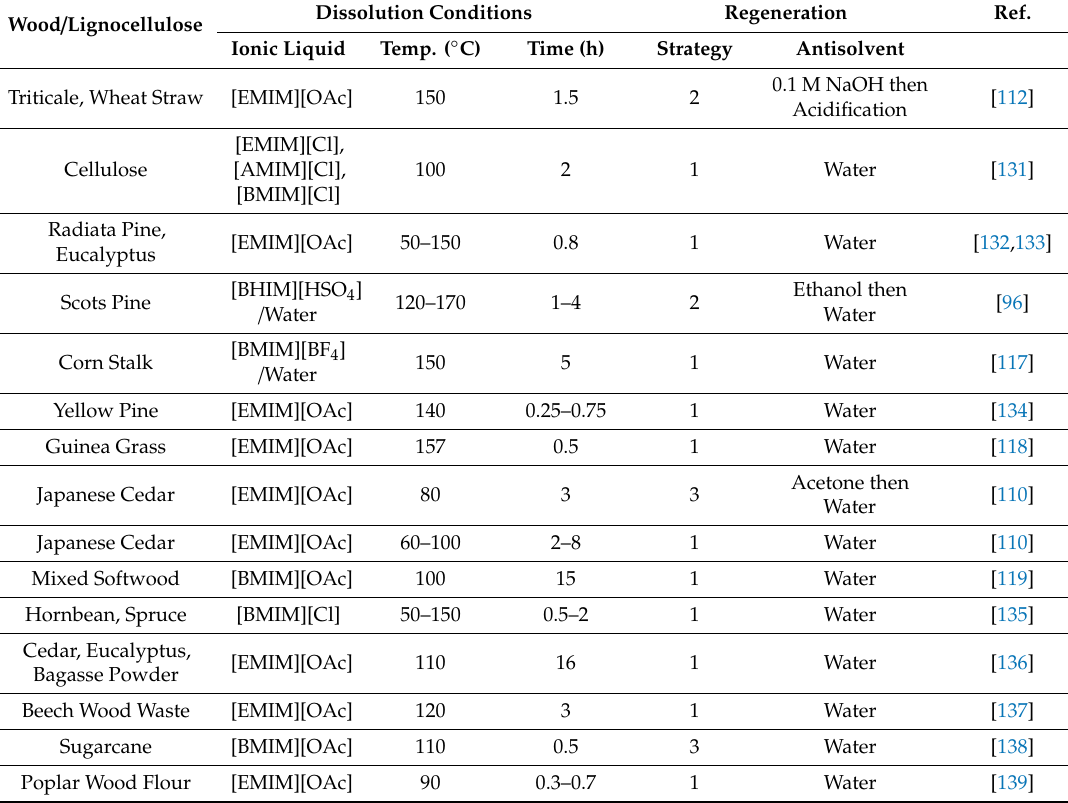
Table 2. Summary of the literature on wood and cellulose dissolution for biofuel